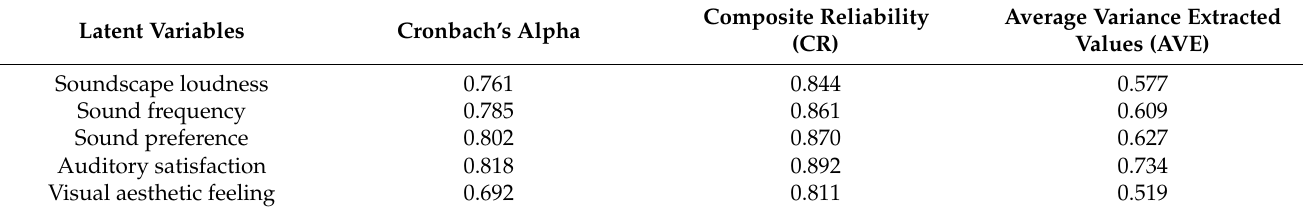
Table 3. Reliability and convergent validity test